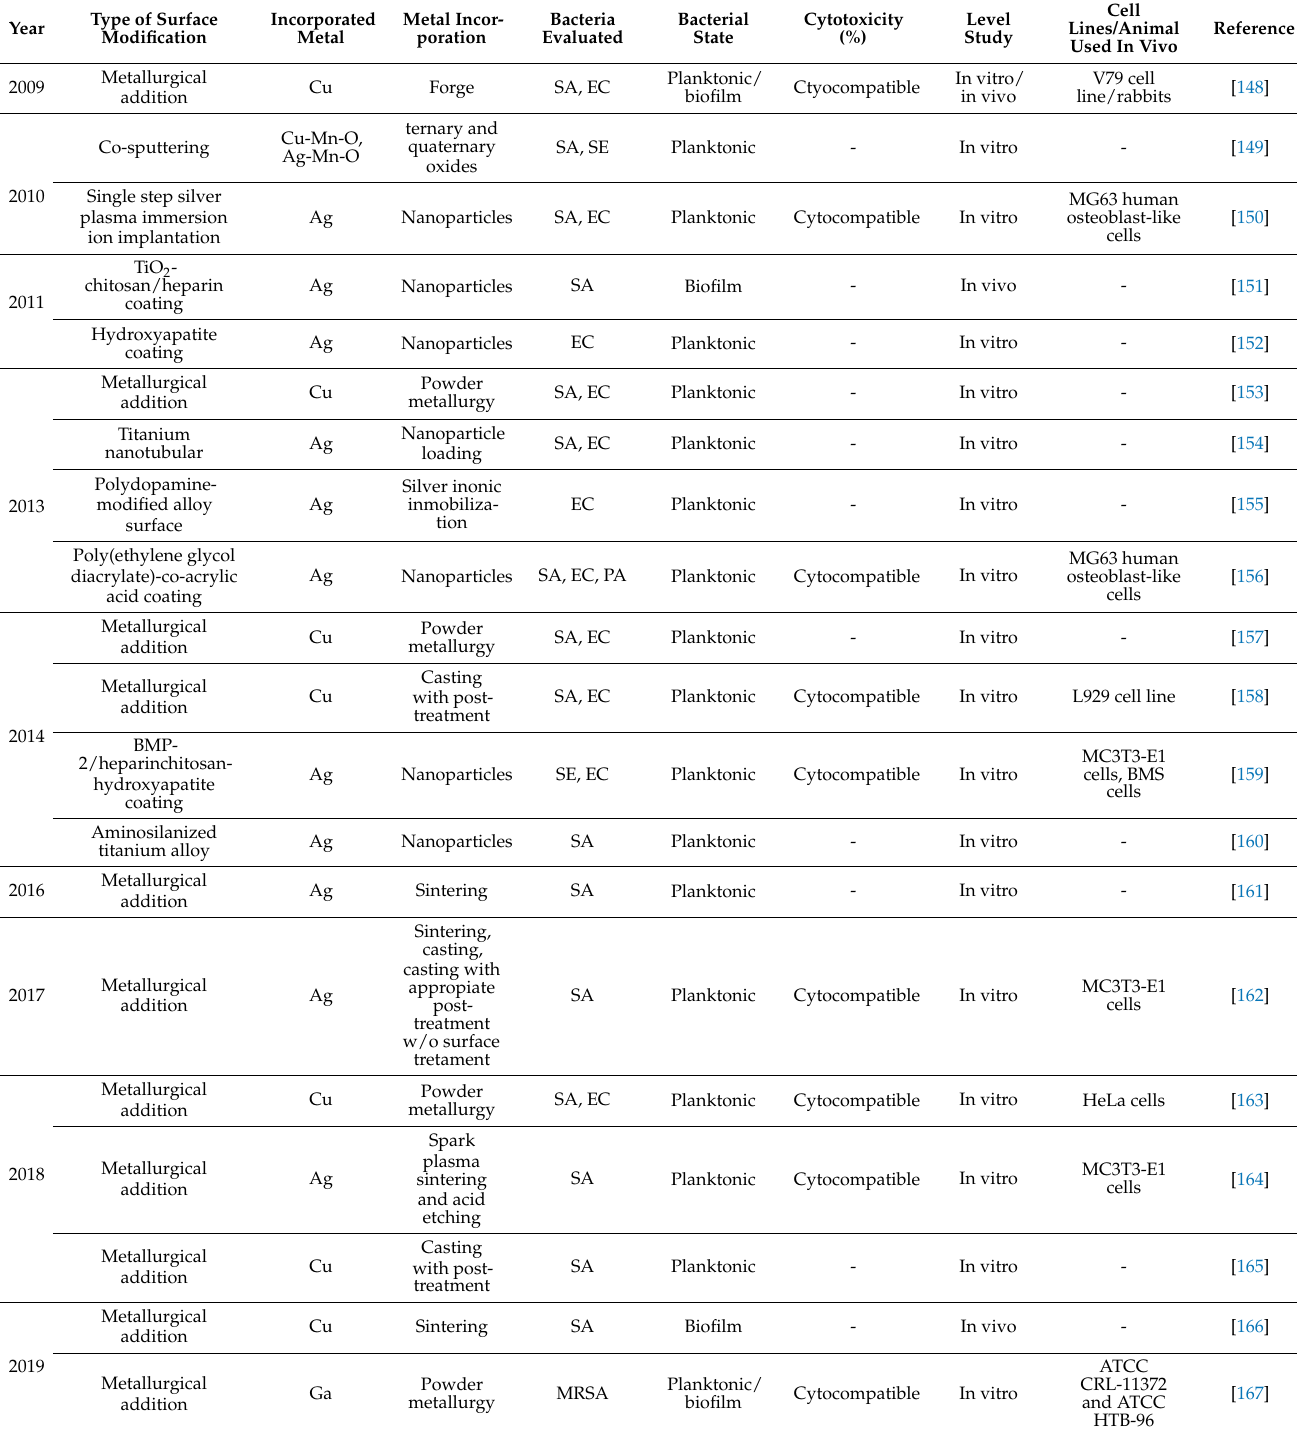
Table 4. Some of the most relevant studies based on heavy metals incorporation for titanium